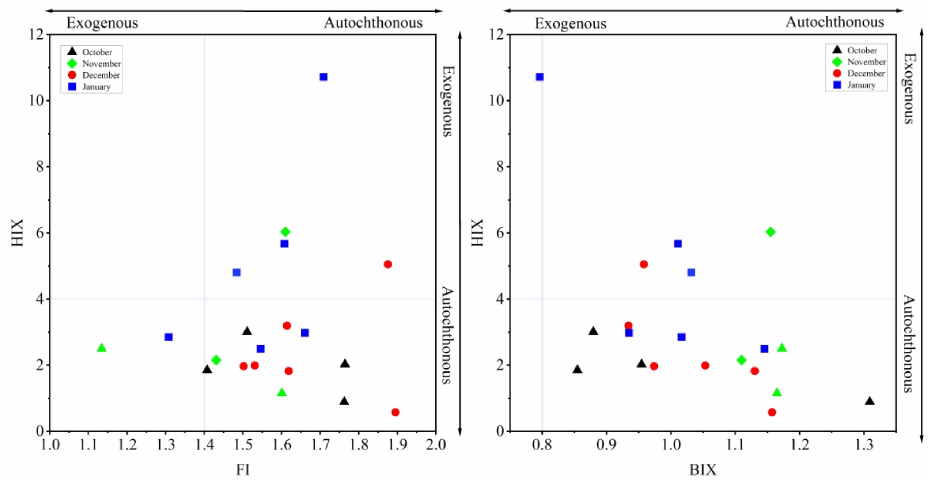
Figure 7. Distribution of drip point FI, HIX, and BIX for October 2020–January 2021 in Daxiao